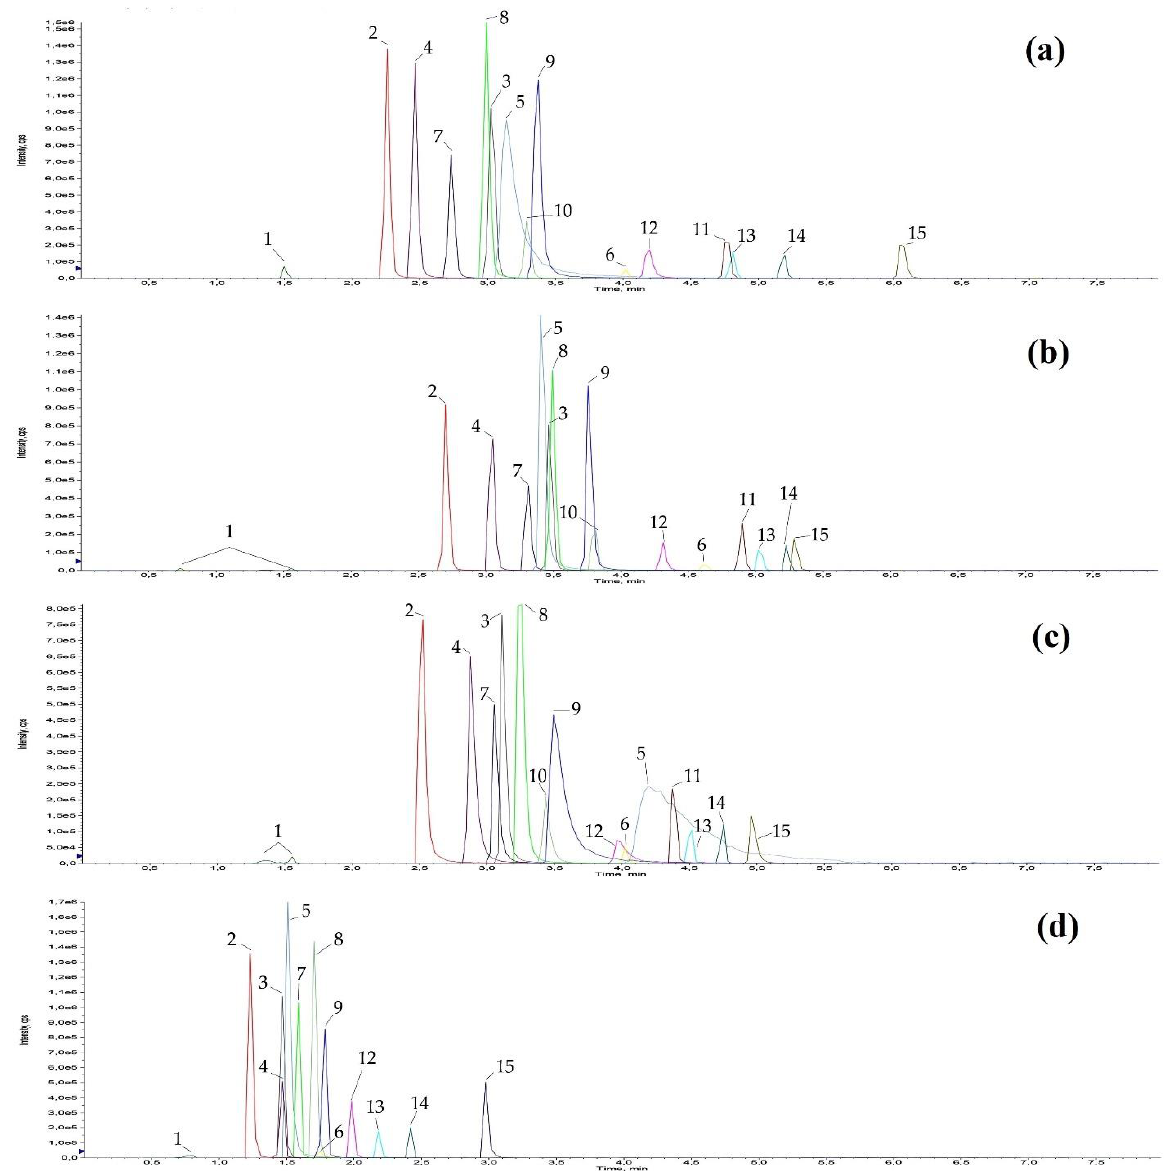
Figure 5. Chromatographic comparison of some of the C18s tested for the analytes separation (2 ng injected). Panel ( a ): Acquity UPLC ® HSS T3; Panel ( b ): CSH™ C 18 ; Panel ( c ):Kinetex ® EVO C 18 ; Panel ( d ): Kinetex ® C 18 . For a simpler visual- ization, the peaks have been indicated with numbers to which the following analytes correspond: 1 atenolol, 2 tramadol, 3 venlafaxine, 4 zolpidem, 5 triprolidine, 6 bromazepam, 7 trazodone, 8 fentanyl, 9 diphenhydramine, 10 escitalopram, 11 cetirizine, 12 cyproheptadine, 13 alprazolam, 14 delorazepam, 15